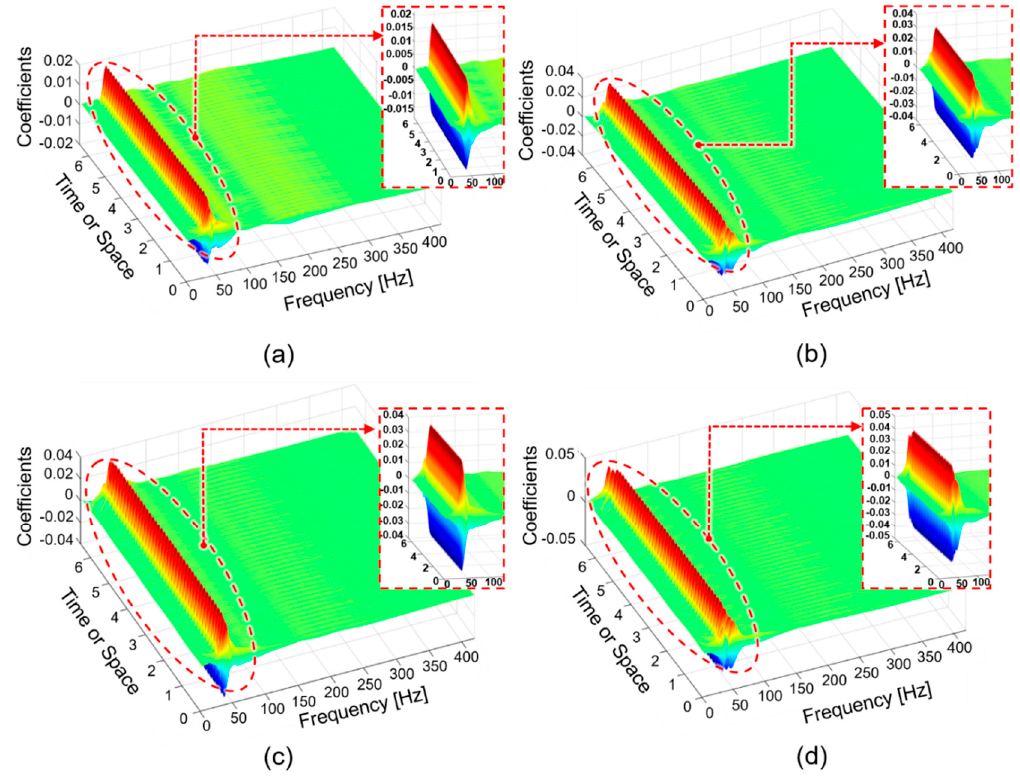
Figure 8. Fast Fourier Transform (FFT) spectra and wavelet maps of signals corresponding to classes ( a ) ‘0.0 g’; ( b ) ’1.6 g’; ( c ) ’2.0 g’; and ( d ) ‘2.8 g’.